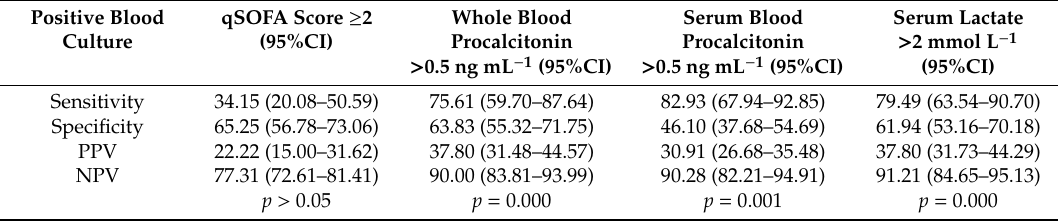
Table 3. Sensitivity and specificity of the qSOFA score, serum lactate and whole blood procalcitonin level for